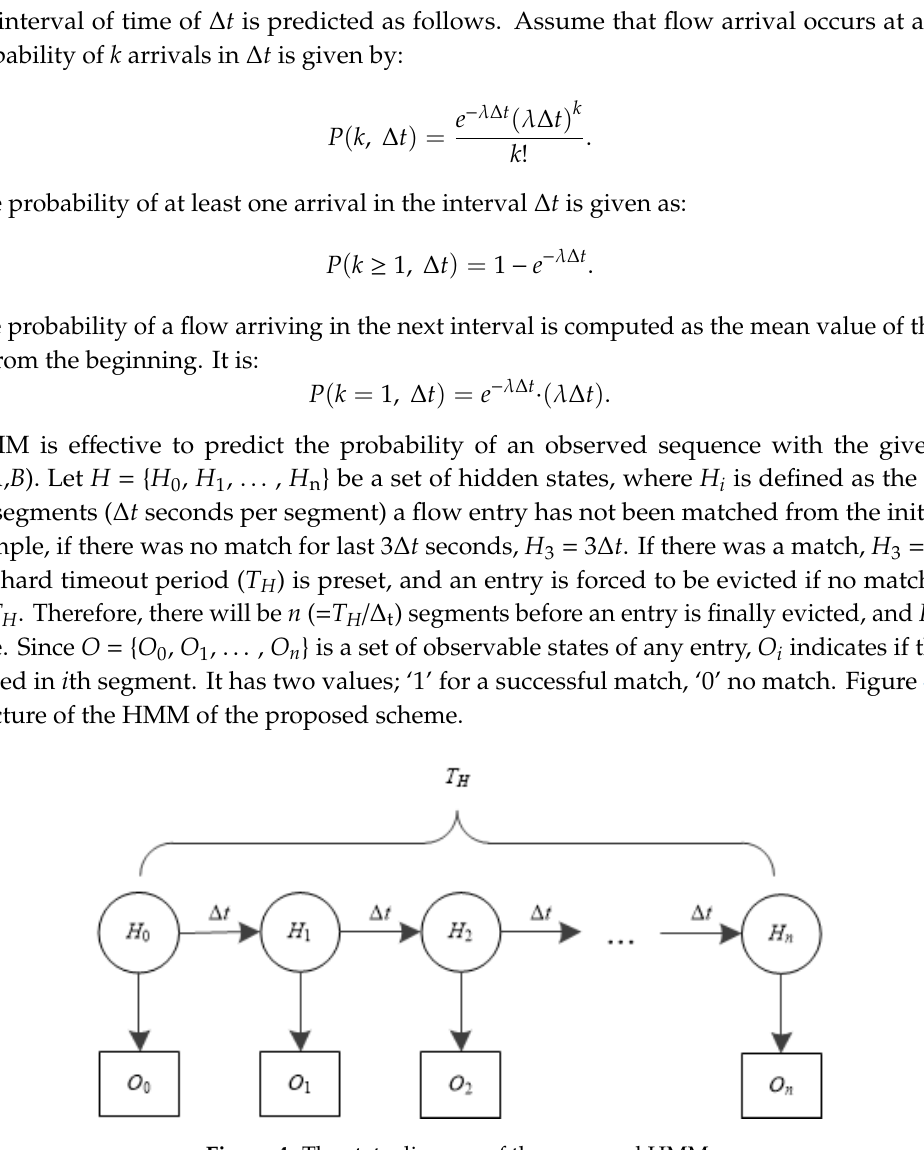
Figure 4. The state diagram of the proposed HMM.